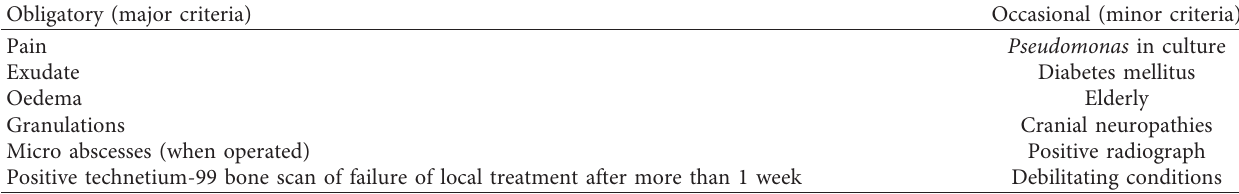
Table 1: Diagnostic criteria of NOE adapted from Cohen & Friedman.